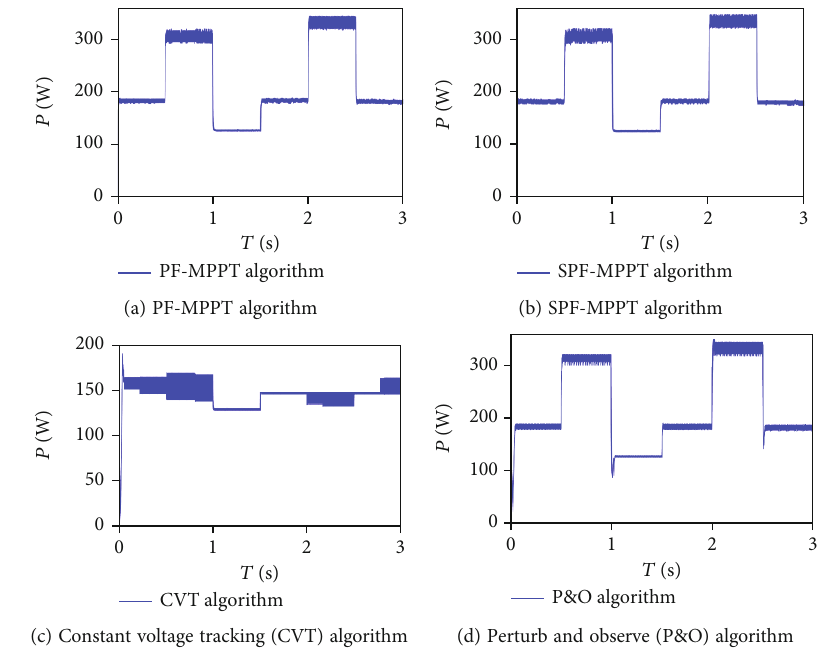
Figure 12: Output power of simulation system.